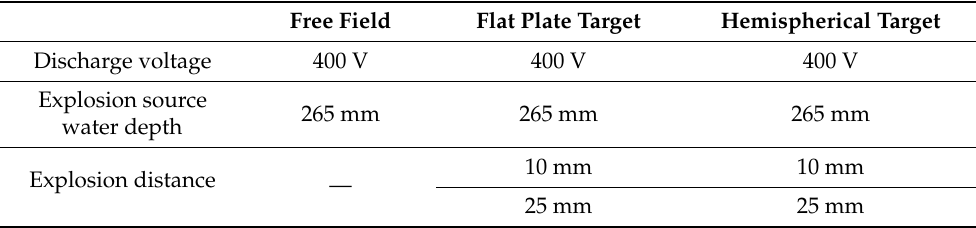
Table 2. Experimental